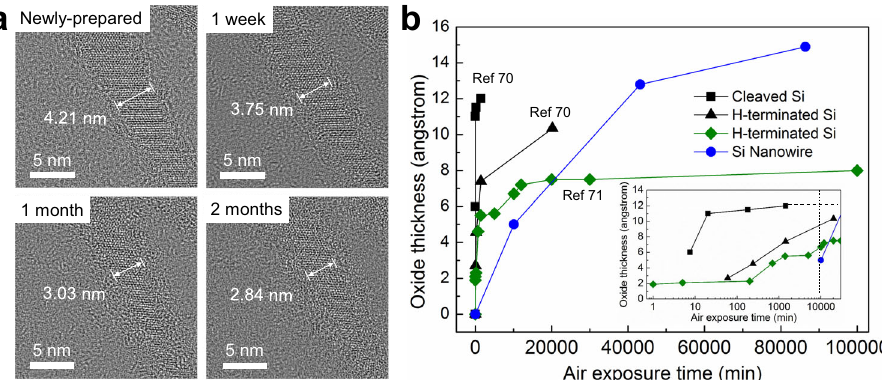
Fig. 4 Stability against oxidation of the vertically aligned ultra-narrow SiNWs. a HRTEM images showing the stability of the ultra-narrow Si nanowire subject to air exposure at room temperature. Note that the identical SiNW was observed in HRTEM for different time durations. The sizes of the crystalline Si cores are measured. b Oxide thickness as a function of exposure time to ambient air 70,71